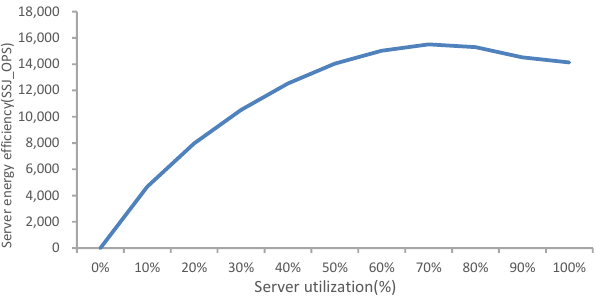
Figure 1. The relationship between a server utilization rate and energy efficiency released in 2019.